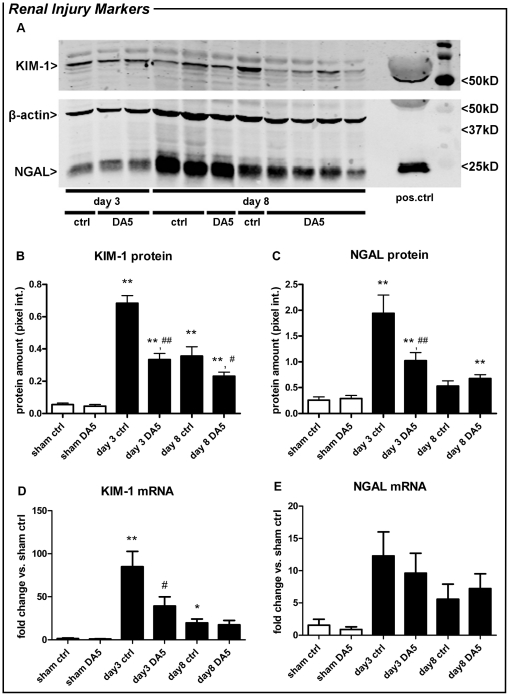
Diannexin (DA5) reduces expression and transcription of renal injury markers after IRI.(A) Representative western blot of kidney homogenate from DA5 and vehicle-treated mice (ctrl), after 3 or 7 days of reperfusion, stained for KIM-1, NGAL and β-actin. Purified KIM-1 and NGAL protein were used as positive control. (B,C,D) When compared to sham operation, KIM-1 and NGAL expression, as well as KIM-1 transcription, were increased in renal tissue 3 and 8 days after IRI induction. DA5 treatment significantly reduced protein expression on day 3 (KIM-1 and NGAL) and day 8 (KIM-1), when compared to vehicle-treated mice (ctrl). Also, DA5 reduced the IRI-induced transcription of KIM-1 on day 3 and day 8. (E) NGAL mRNA expression was not significantly elevated on day 3 or day 8 post-IRI. CT-values for corresponding β-actin were 17.2±3.2 for KIM-1 and 18.5±2.9 for NGAL. Values are means ± SEM. *P<0.05, **P<0.001 vs. sham group; #
P<0.05, ##
P<0.001 vs. ctrl group. n = 5 for sham operated mice and n = 10 for all other groups.